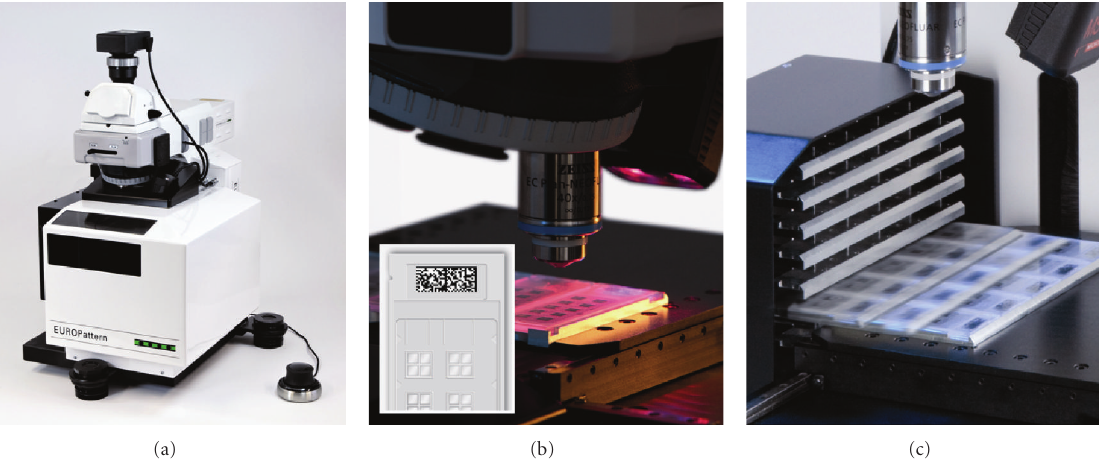
Figure 1: EUROPattern Microscope for automated acquisition of high-resolution immunofluorescence images. (a) Motorized microscope including camera, controlled LED, microscope control device, optional eyepieces, (b) matrix code reader, and (c) slide magazine. The microscope stage and the magazine are surrounded by a casing keeping out the sunlight and protecting the substrate fluorescence from fading. The microscope is part of the EUROPattern Suite, which additionally contains a laboratory management software (EUROLabO ffi ce) and an automatic pattern recognition software (EUROPattern).